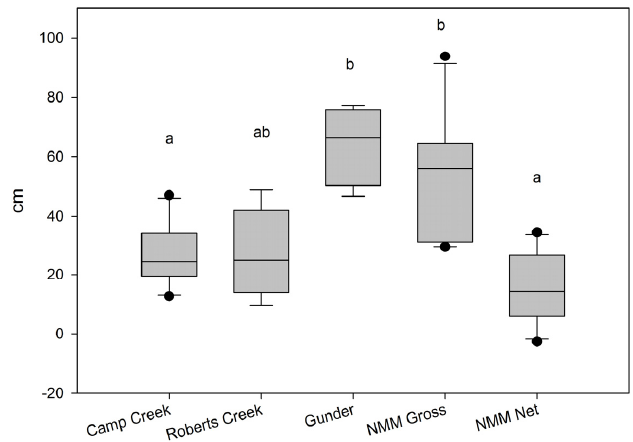
Figure 8. Cumulative lateral recession by alluvial unit (cm), NMM Gross, and NMM Net, Walnut Creek, Iowa. Lower-case letters indicate significant difference between units ( p value < 0.1).